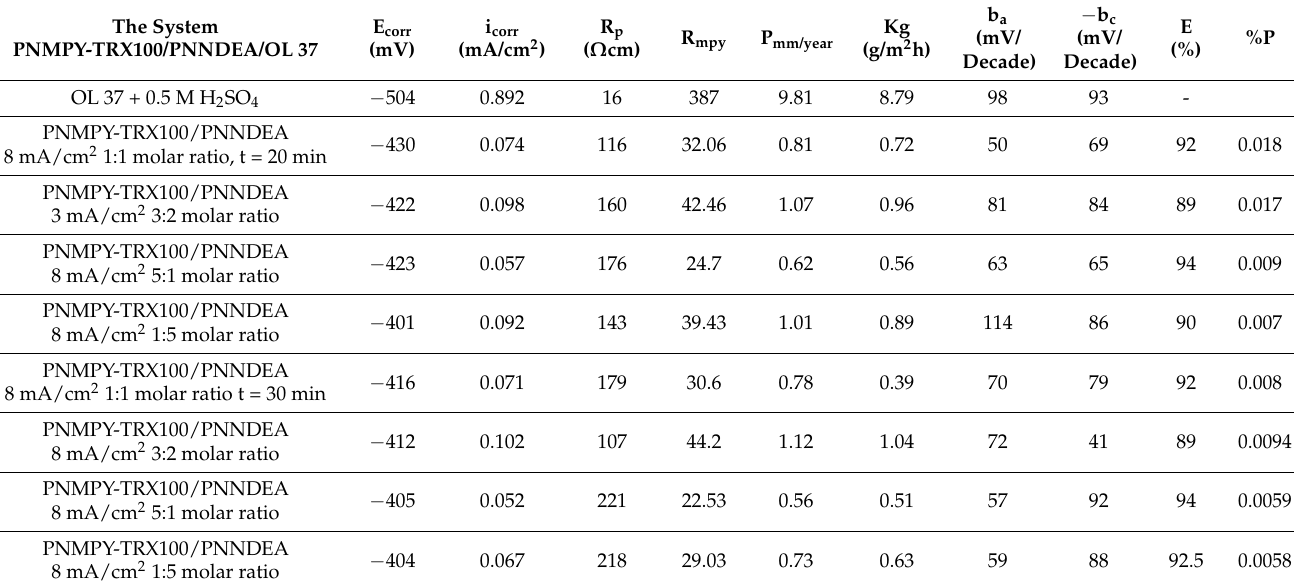
Table 3. Kinetic Corrosion Parameters of Coated and Uncoated OL37 Electrode in 0.5 M H 2 SO 4 Solution at 25 ◦ C. The System PNMPY-TRX100/PNNDEA/OL 37